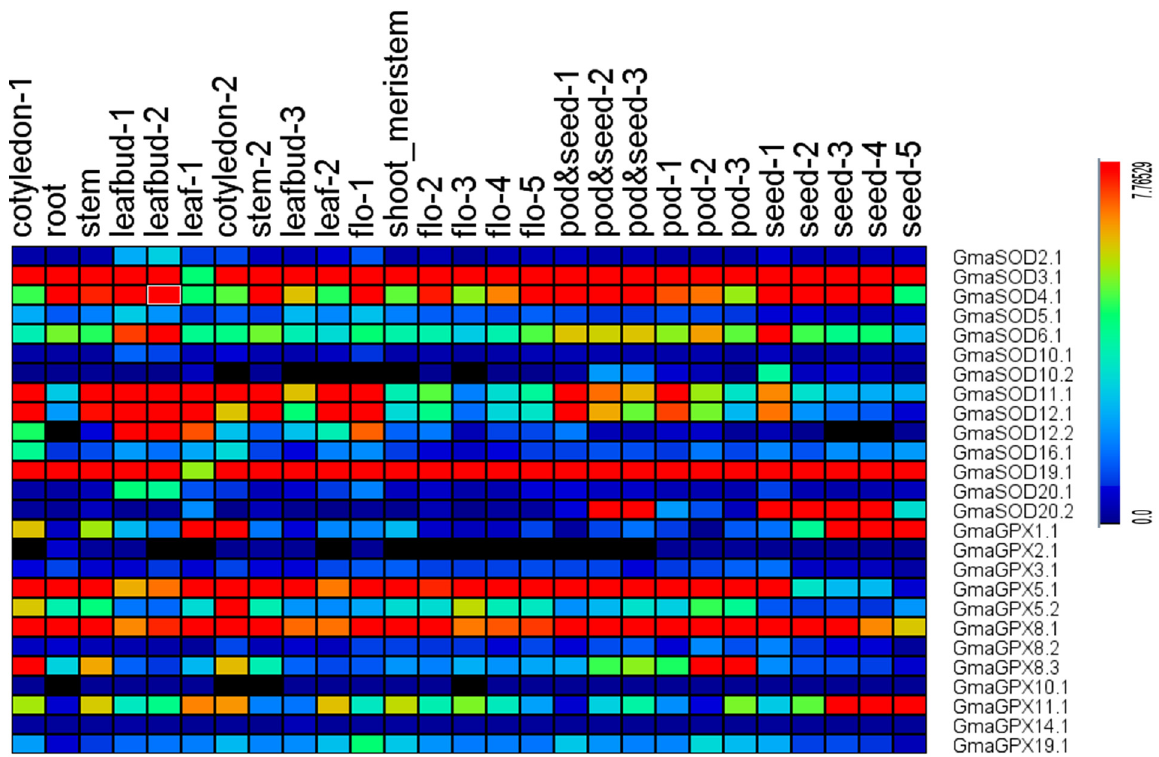
Figure 9. Expression profiles of the SOD and GPX genes in soybean, including different organs, tissues, and developmental stages. Data were normalized based on the mean expression value of each gene in all tissues analyzed. Flo-1: 1st flower, Flo-2: 2nd flower, Flo-3: 3rd flower, Flo-4: 4th flower, Flo-5: 5th flower.